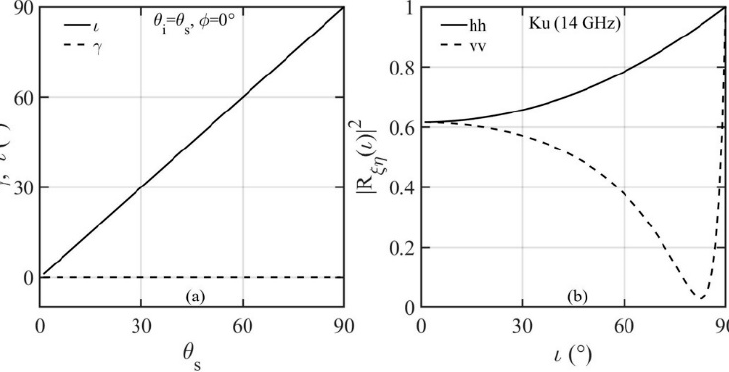
Figure 14. Relevant parameters governing in-plane specular reflection ( θ i = θ s , ϕ s = 0°): ( a ) local incidence angle ι and facet angle γ , ( b ) surface reflectivity.